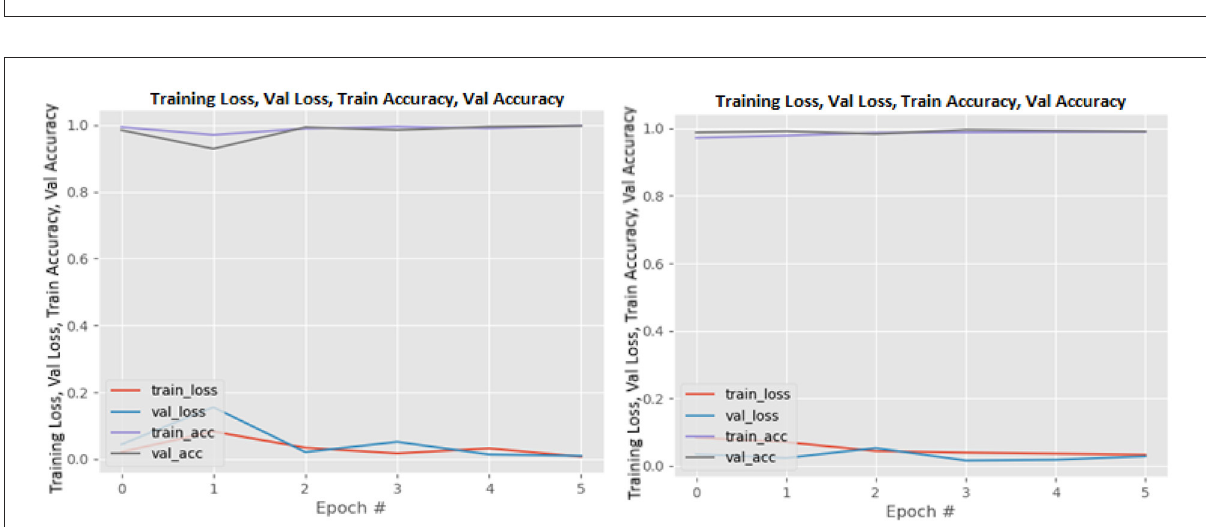
FIGURE18 VGG19 without data augmentation (left image) and with data augmentation (right image).